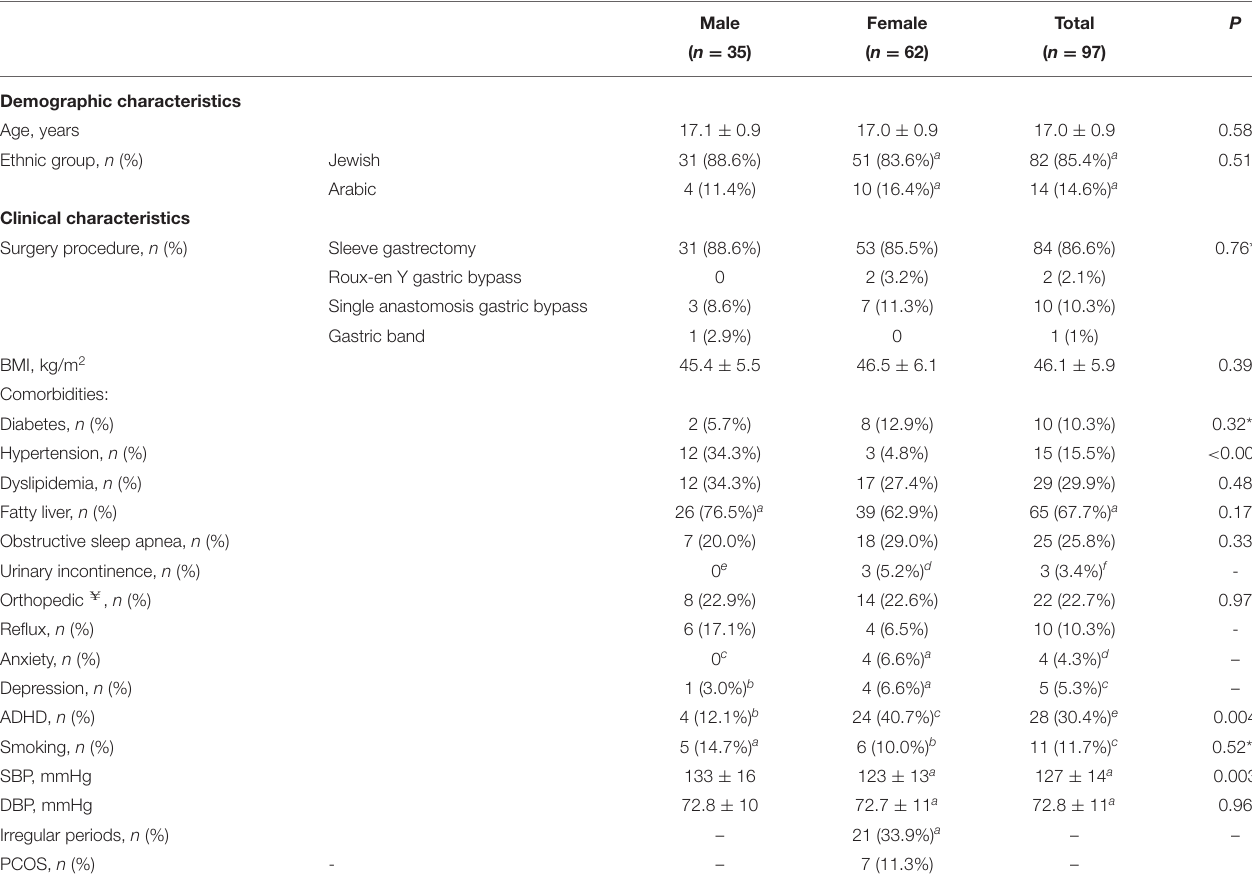
TABLE 1 | Baseline characteristics of the participants before metabolic bariatric